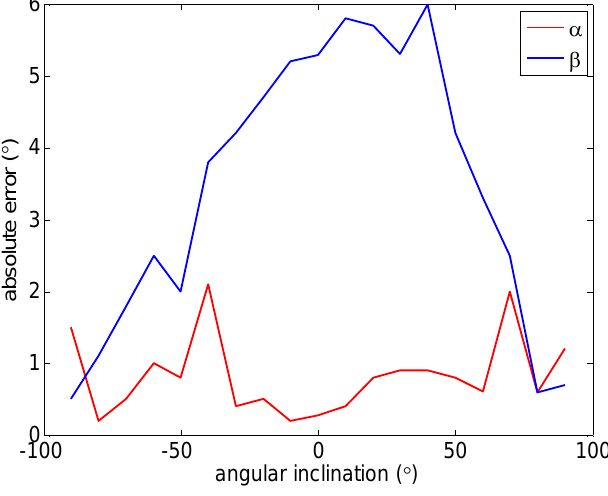
Figure 6. Absolute error in the estimation of the vertical and horizontal inclination.